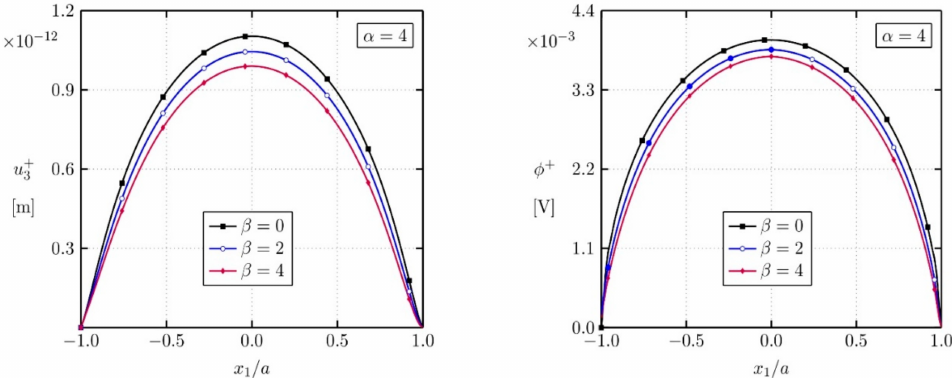
Figure 5. Crack opening-displacements u + di ff erent factors β